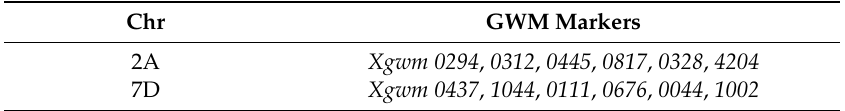
Table 2. The GWM markers polymorphic among donor lines i:S29 Pp-D1Pp3 PF , i:S29 Pp-D1Pp3 P , and recipient cultivars used for marker-assisted